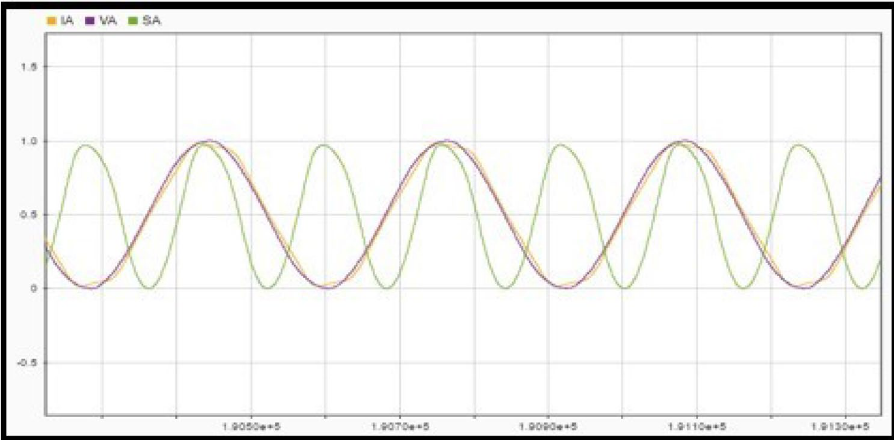
Figure 18. Instant current, voltage, and